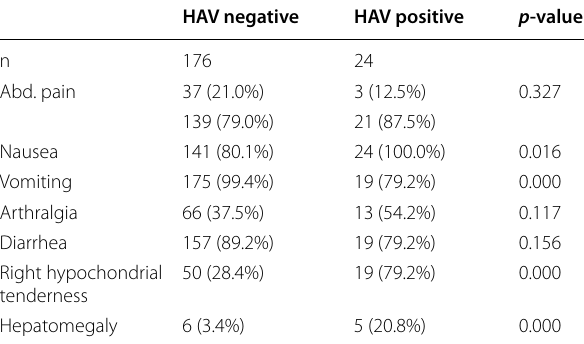
Table 3 Clinical manifestations of HAV negative and positive groups